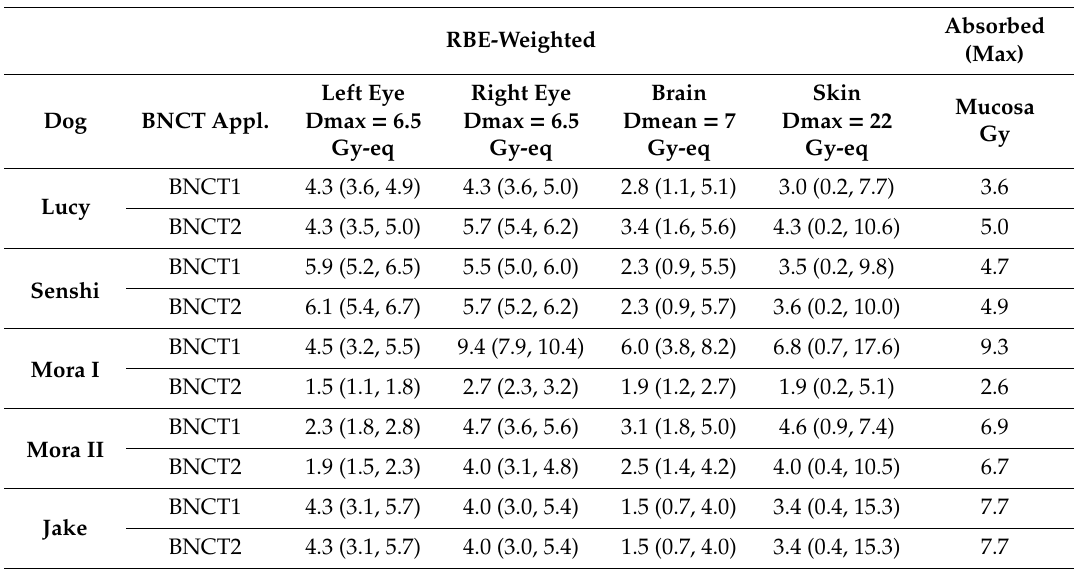
Table 2. Normal tissue doses for the 5 veterinary patients treated with the B2 clinical beam of the RA-6 reactor. BNCT1 and BNCT2 correspond to the first and second BNCT application (appl.) (3–5 weeks apart),